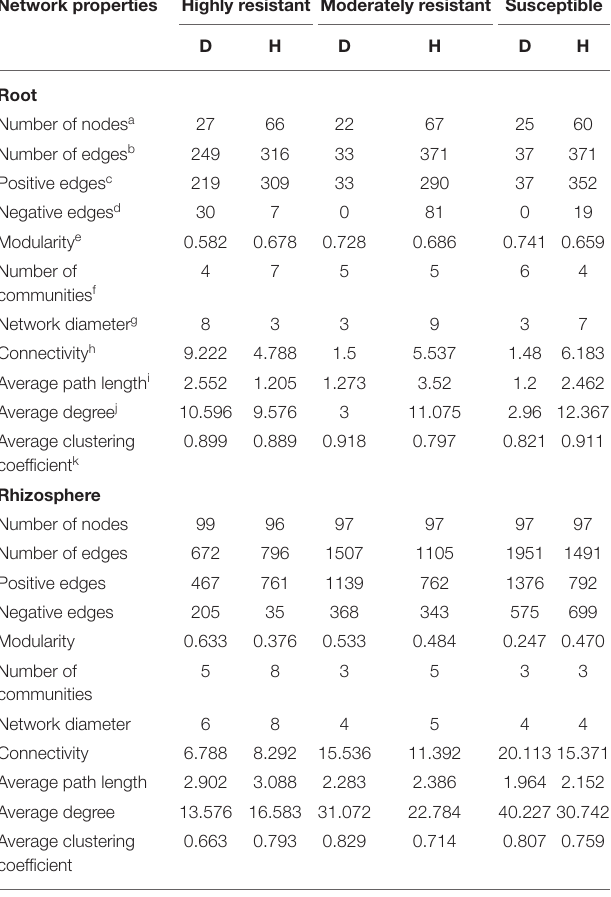
TABLE 3 | Correlations and topological properties of watermelon root and rhizosphere microbiome networks. Network properties Highly resistant Moderately resistant